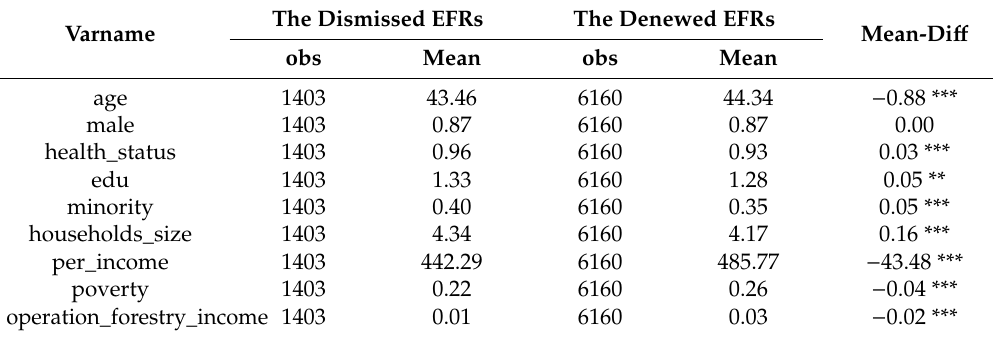
Table 7. Di ff erences between the characteristics of dismissed and renewed: meant t